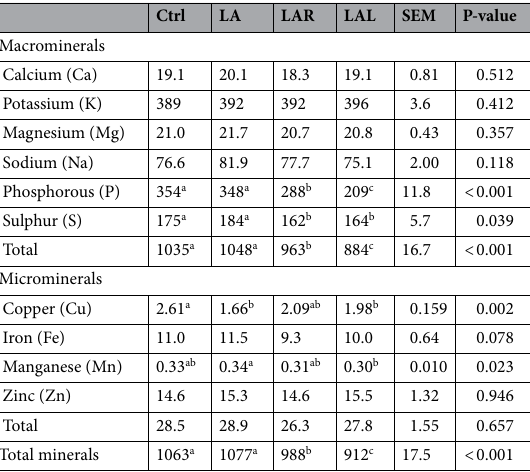
Table 4. Effect of diet on the hepatic mineral profile (mg/100 g of liver) of piglets. Ctrl control diet, LA control + 10% Laminaria digitata , LAR LA + 0.005% Rovabio ® Excel AP, LAL LA + 0.01% alginate lyase, SEM standard error of the means. Values with different superscripts are significantly different at P < 0.05.